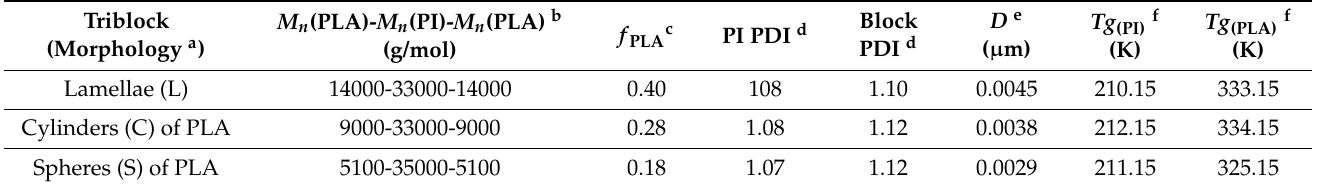
Table 4. PLA-PI-PLA microstructural data.